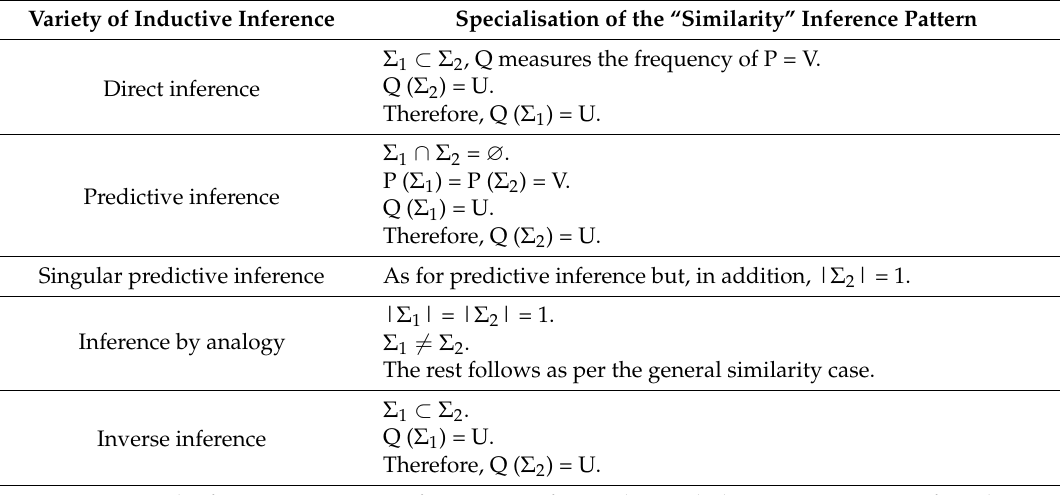
Table 2. Carnap’s taxonomy of inductive